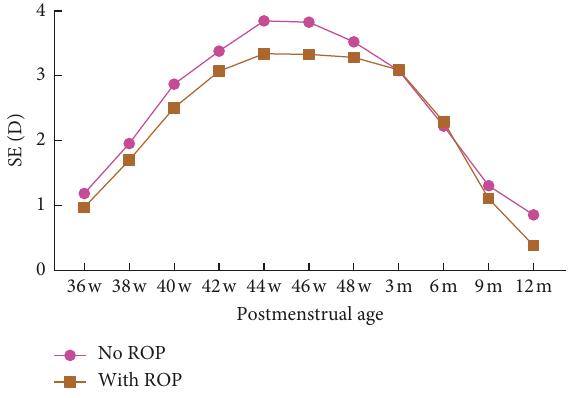
Figure 6: Correlation between SE and severe ROP. SE, spherical equivalent; D,